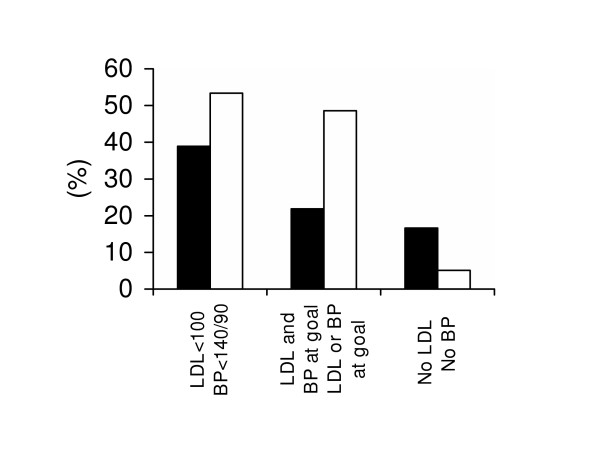
Guideline concordance for LDL cholesterol and blood pressure. * Patients were grouped into exclusive categories for "LDL and BP at goal' and 'LDL or BP at goal'. Therefore, patients at both LDL and BP goal were not placed in the numerator for the category 'LDL or BP at goal'.